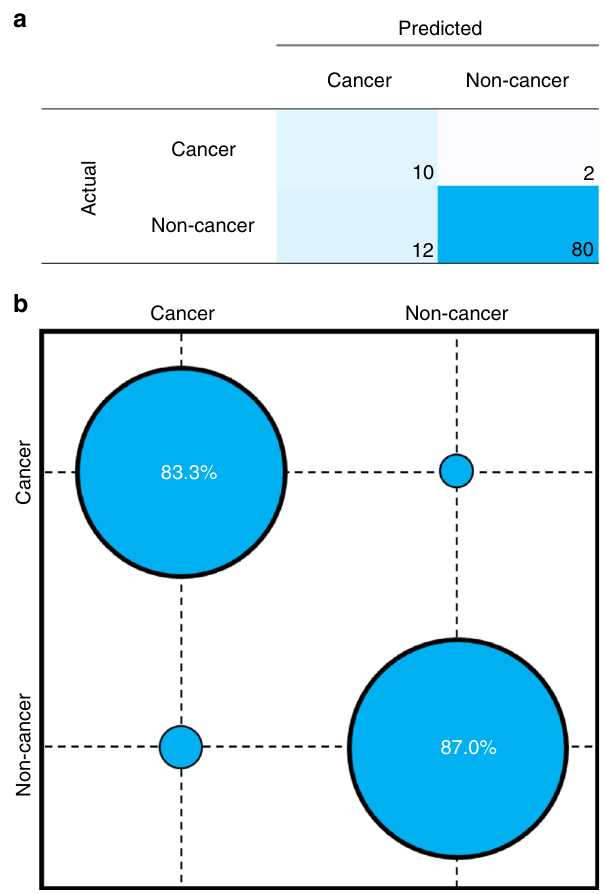
Fig. 6 Disease prediction of a prospective patient cohort with suspected brain cancer using ATR-FTIR spectroscopy. Blind analysis was conducted using an SVM algorithm previously trained on retrospective patient cohort. a Confusion matrix of classi fi cation on a per patient basis with b confusion ball visualisation of sensitivity and speci fi